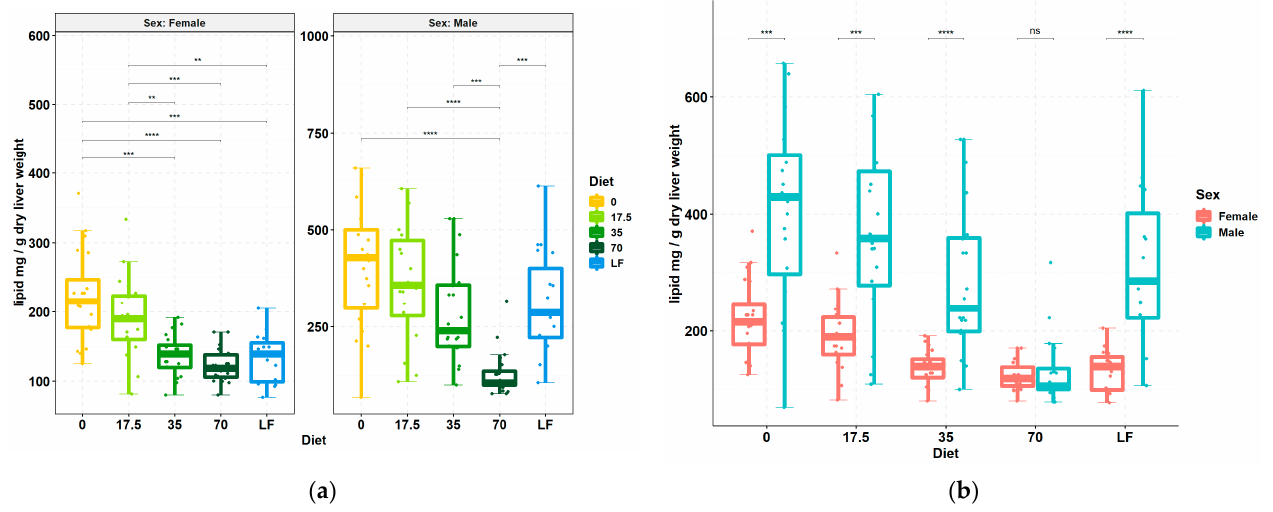
Figure 1. Effect of dietary bean on the liver lipid content. Box plots report amount of hepatic lipid (in mg) normalized to g of dry liver weight across the diet groups and sex cohorts. Diets are indi- cated by the percent (%) of dietary protein provided by bean, including a low-fat (LF) diet as a negative control. Kruskal–Wallis testing showed significant differences by the diet effect ( χ 2 = 41.598, p -value = 2.021× 10 − 8 in the female cohort; χ 2 = 40.15, p -value = 4.029 × 10 − 8 in the male cohort). ( a ) Pairwise comparisons between the diet group were conducted using the post-hoc Dunn test; ( b ) Pairwise comparison between sex cohorts were tested with the Mann–Whitney U test. The Benja- mini–Hochberg method was used for the multiple testing correction of p -values. ** p -value < 0.01; *** p -value < 0.001; **** p -value < 0.0001.